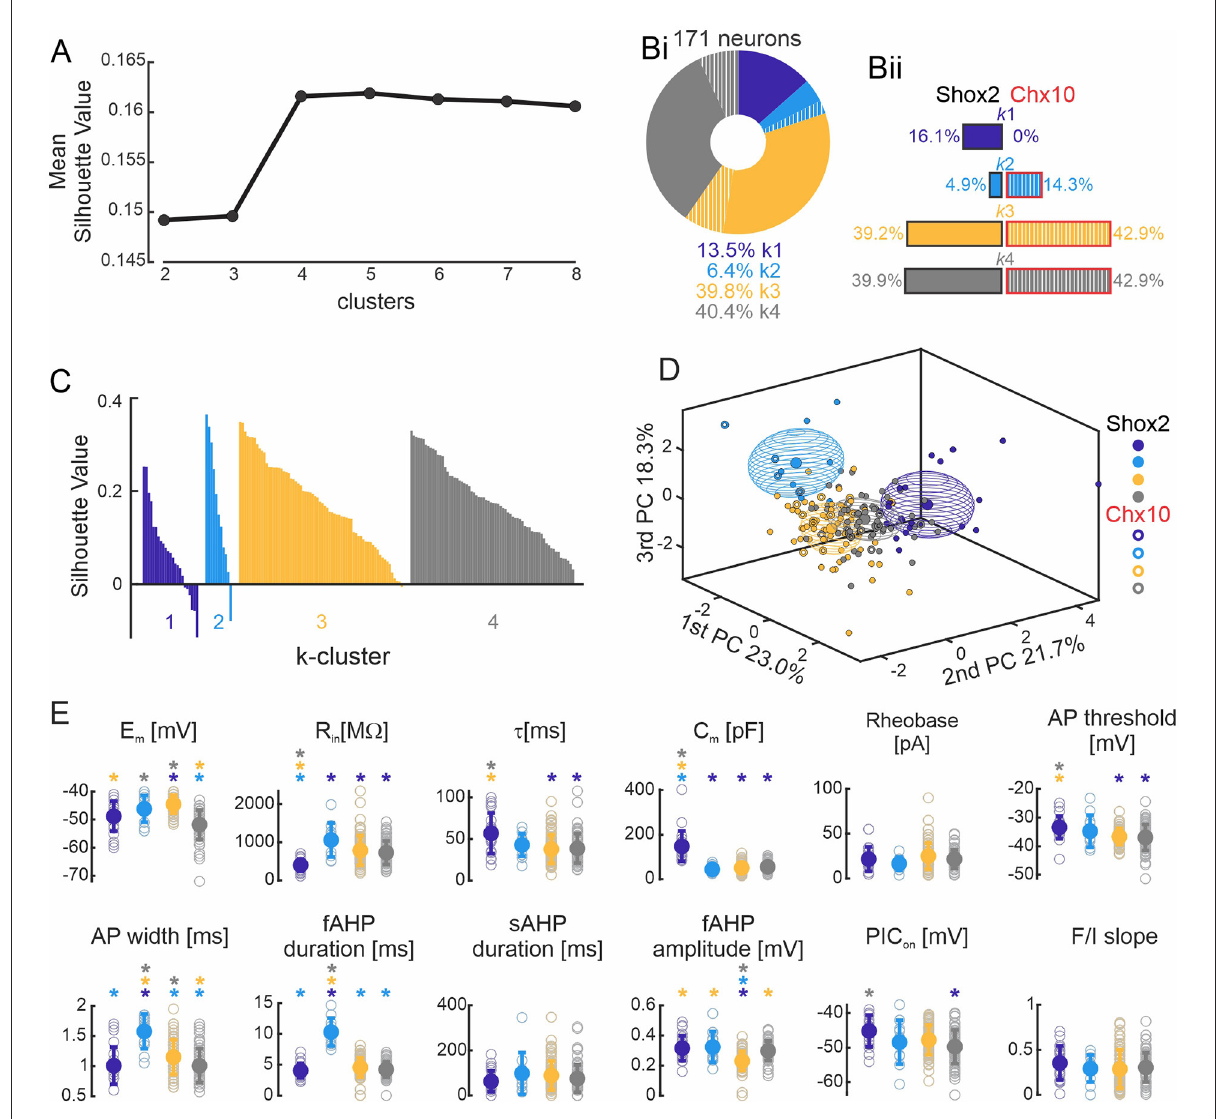
FIGURE5 k -means clustering. (A) Plot of the highest silhouette values for each number of clusters (k, x axis). (Bi) Incidence of the four k clusters in 171 neurons, with 83.6% of the neurons from the Shox2 population (solid) and 16.4% were Chx10 neurons (hatched). k1 cluster (purple, n = 23), k2 cluster (cyan, n = 11), k3 cluster (yellow, n = 68), and k4 cluster (gray, n = 69). The same color code is used throughout the figure. (Bii) Incidence of k clusters observed in 143 Shox2 neurons (left): k1 cluster ( n = 23), k2 cluster ( n = 7), k3 cluster ( n = 56) and k4 cluster ( n = 57). Incidence of the k clusters observed in 28 Chx10 neurons (right): k1 ( n = 0), k2 cluster ( n = 4), k3 cluster ( n = 12), and k4 cluster ( n = 12). (C) Plot of the cluster silhouette values to demonstrate how similar the individual neurons are to the neurons of their own clusters. Each bar represents a single neuron. (D) Three-dimensional representation of all neurons (Shox2 filled dots, Chx10 unfilled dots) on the three principal components (same as Figure 2B but different angle displayed). Ellipsoids are centered on the mean for the three first PC and semi-axes are generated by the standard deviation of each of the three first PCs. (E) Comparisons of electrophysiological properties of the neurons from k1, k2, k3 and k4 clusters. Filled circle represents the mean and error bars the standard deviation, unfilled gray circles represent individual neurons. * p < 0.05, one-way ANOVA with Tukey post-hoc test or Kruskal-Wallis with Dunn’s post-hoc test. * significantly different from the corresponding color coded group.